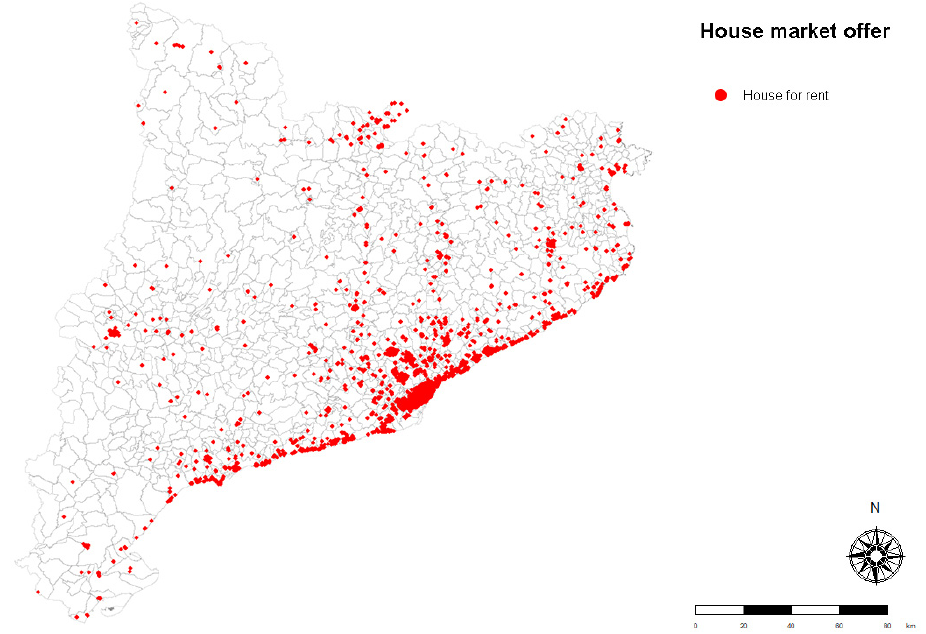
Figure 6. Map of real estate rental o ff er (each point is a house). Geolocalisation, Atypical Values, Errors, and Debugging the Web Scraping The data obtained from the web scraping were used to localise each home in its town and district of reference. Of the total number of homes obtained ( n = 12,796), n = 11,289